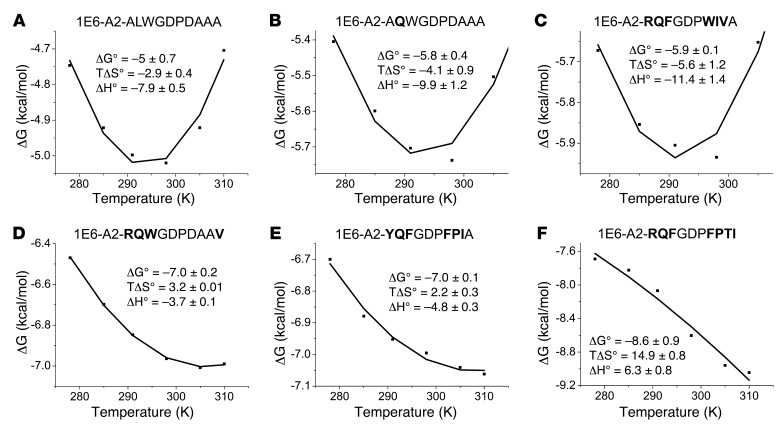
Thermodynamic analysis of the 1E6 TCR with A2-ALWGPDPAAA and the APLs.Eight serial dilutions of the 1E6 TCR were injected, in duplicate, over each immobilized APL and A2-ALW at 5°C, 13°C, 18°C, 25°C, 30°C, and 37°C. The equilibrium binding constant (KD) values were calculated using a nonlinear curve fit (y = [P1x]/[P2 + X]), and thermodynamic parameters were calculated according to the Gibbs-Helmholtz equation (ΔG° = ΔH − TΔS°). The binding free energies, ΔG° (ΔG° = RTlnKD), were plotted against temperature (K) using nonlinear regression to fit the 3-parameters van’t Hoff equation (RT ln KD = ΔH° – TΔS° + ΔCp°[T-T0] – TΔCp° ln [T/T0] with T0 = 298 K). (A) 1E6-A2-ALWGPDPAAA; (B) 1E6-A2-AQWGPDPAAA; (C) 1E6-A2-RQFGPDWIVA; (D) 1E6-A2-RQWGPDPAAV, (E) 1E6-A2-YQFGPDFPTA; and (F) 1E6-A2-RQFGPDFPTI.